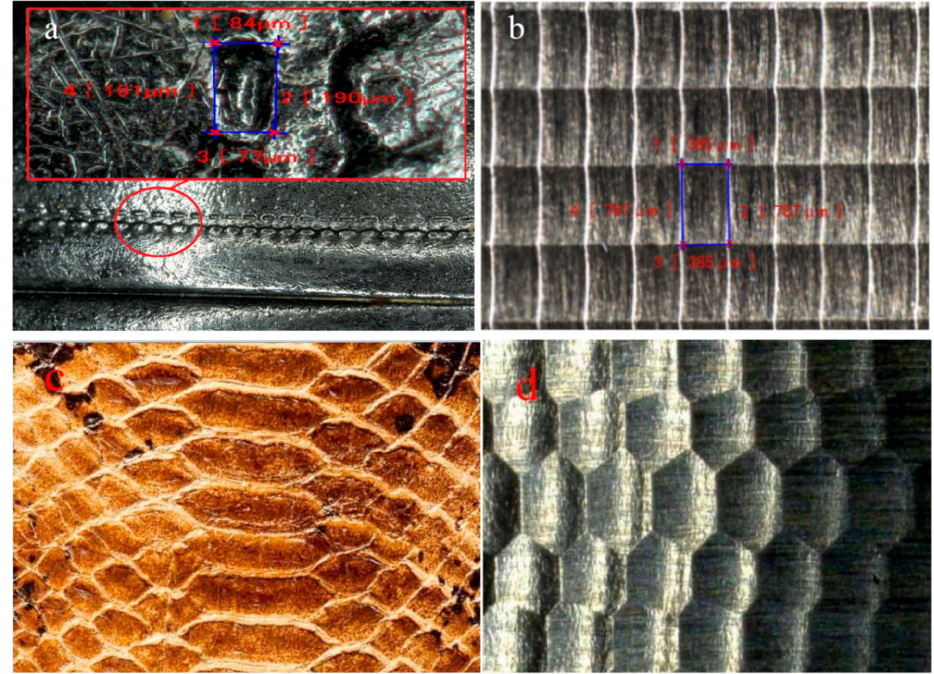
Figure 1. Different bionic design prototypes and milling process bionic non-smooth pit surface morphology. ( a ) Bionic design pattern of quadrilateral pits on surface of dung beetle; ( b ) quadrilateral bionic pits are obtained by ball-head milling; ( c ) hexagonal bionic design pattern on abdomen of desert belly snake; ( d ) hexagonal bionic pit morphology produced by ball-end